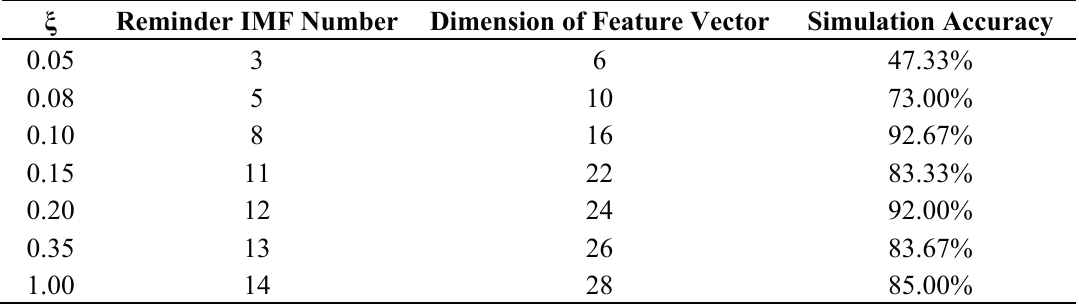
Table 3. Change rule of the reminder IMF number and the prediction accuracy at different ξ